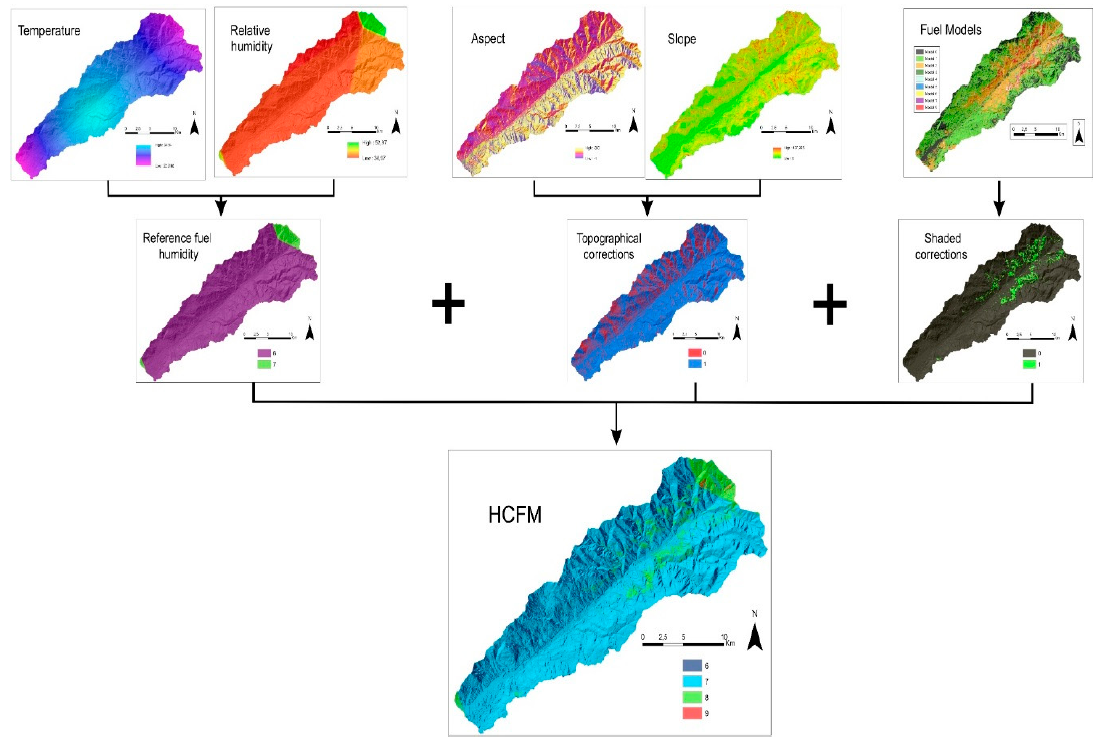
Figure 9. Humidity of the dead fine fuel (HCFM) calculation process.